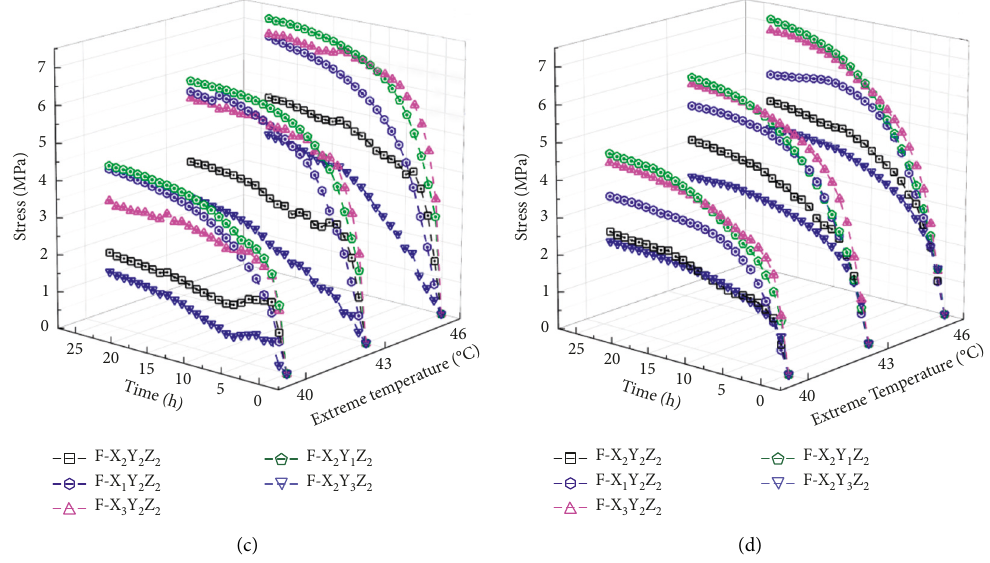
Figure 9: Longitudinal stress-time history curve of the scaled specimen. (a) The constraint track slab, (b) the constraint concrete base, (c) the freedom track slab, and (d) the freedom concrete base. Table 5: Expression to calculate the correlation coefficient.